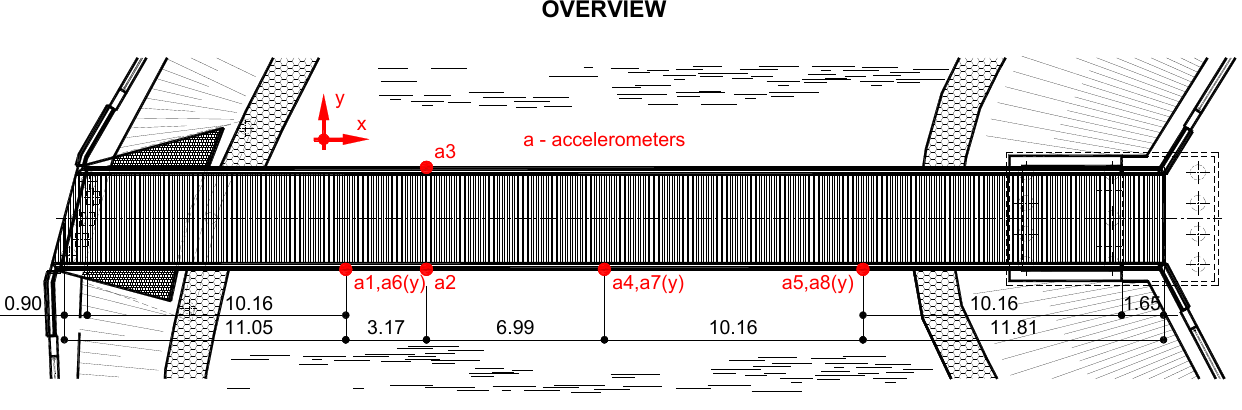
Figure 21. Location of the measurement devices.